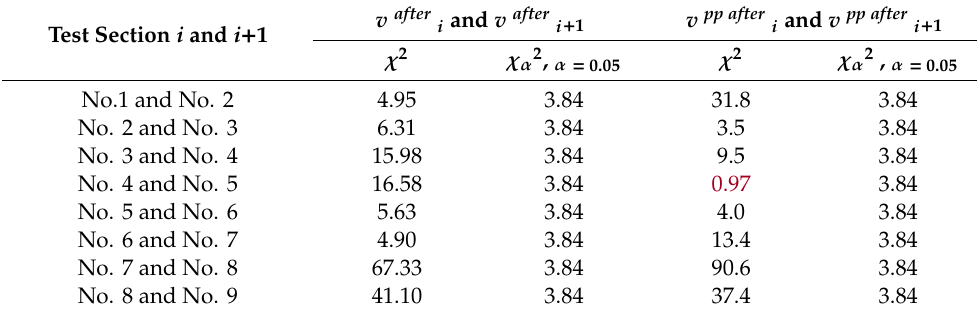
Table A7. Results of median tests on subsequent test sections (free speed v after and vehicle flow speed v pp after